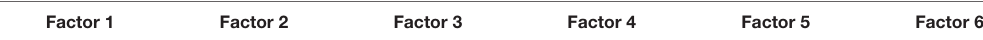
TABLE 5 | Rotated component